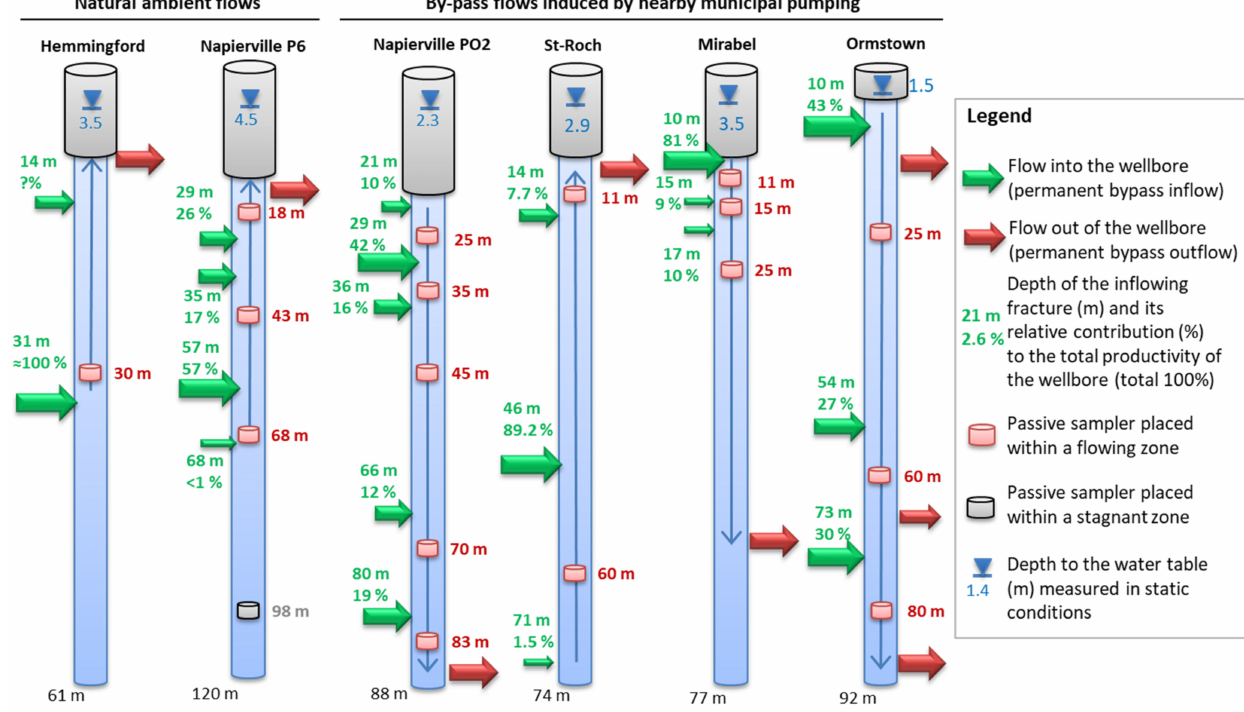
Figure 5. Placement of passive samplers for wells impacted by permanent flows (natural ambient flows and bypass flows induced by nearby municipal